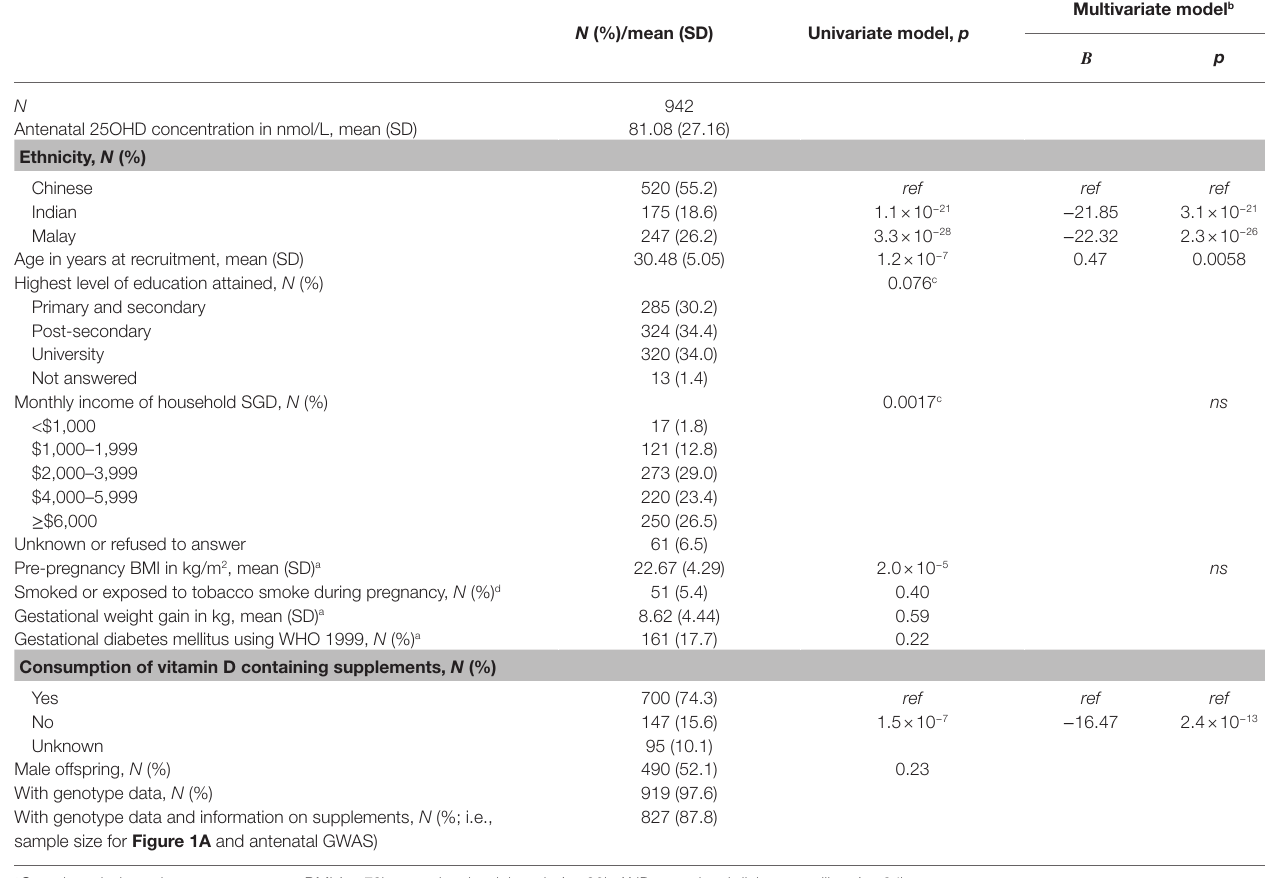
Multivariate model